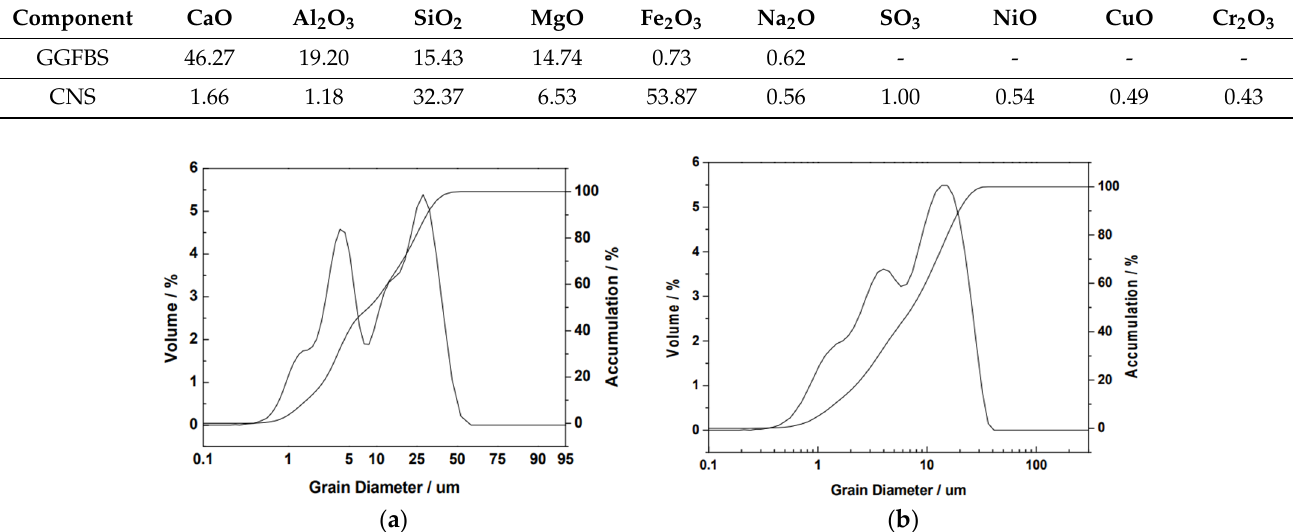
Table 1. Chemical composition of GGBFS and CNS (wt.%).